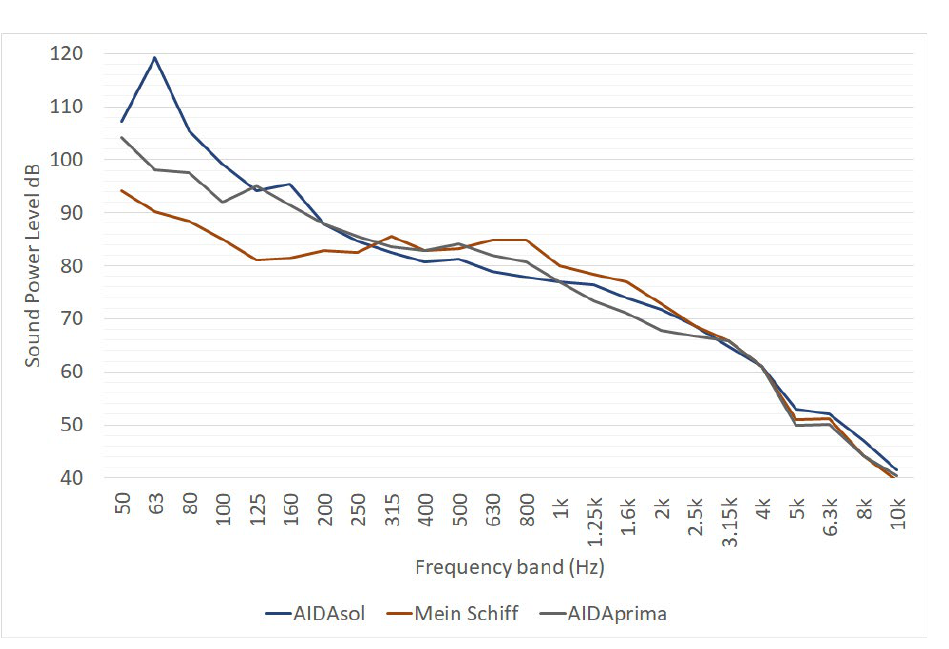
Figure 8. One-third octave sound power spectra of cruise ship funnel of three vessels, as reported in [20]. L W is expressed in dB for point sources, in dB/m for linear sources and in dB/m 2 for area sources.